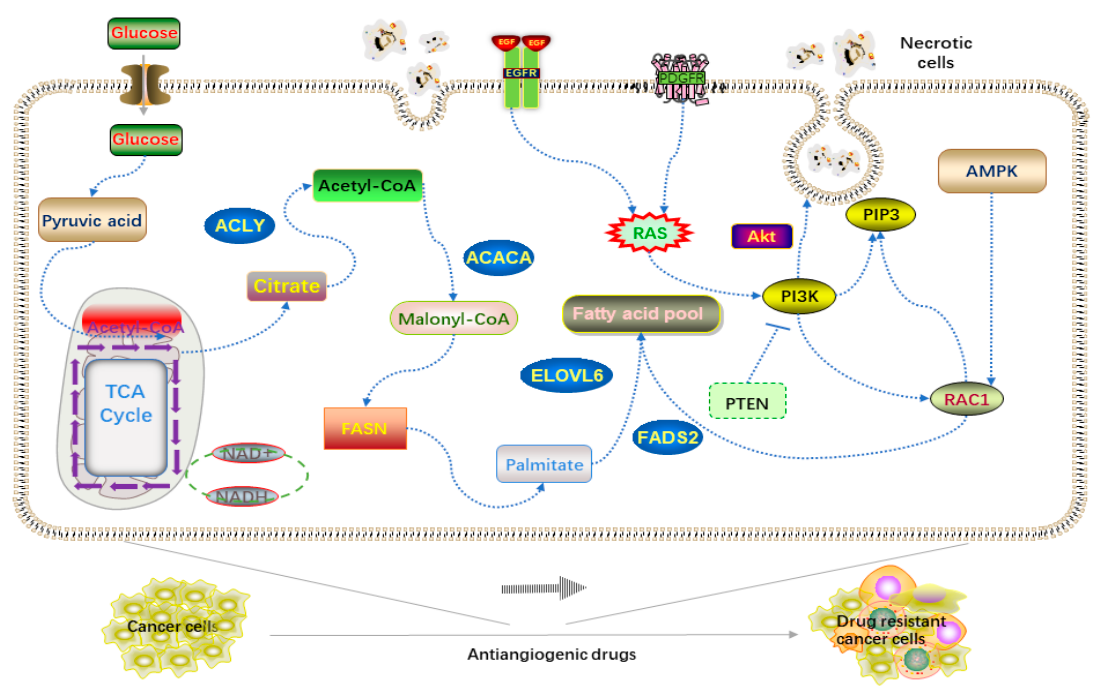
Figure 2. Mechanism of drug resistance of tumor cells induced by anti-angiogenic drugs (AADs).